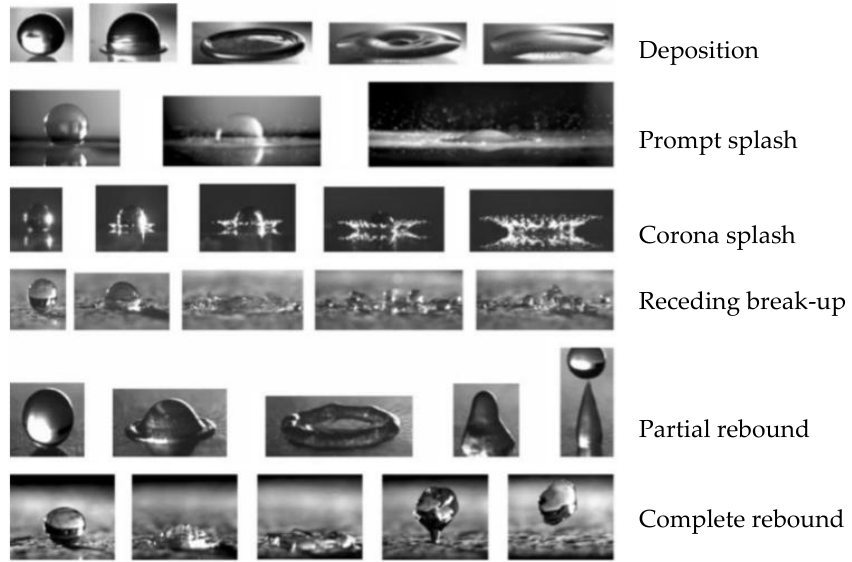
Figure 1. Droplet impact regimes on dry surfaces (reproduced with permission from [65]).